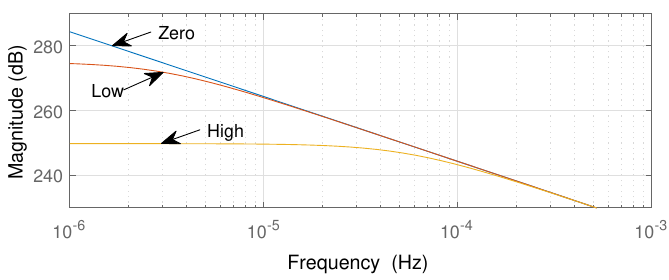
∆ P s ( s ) ∆ Q ( s ) for three levels of external fluid leakage.